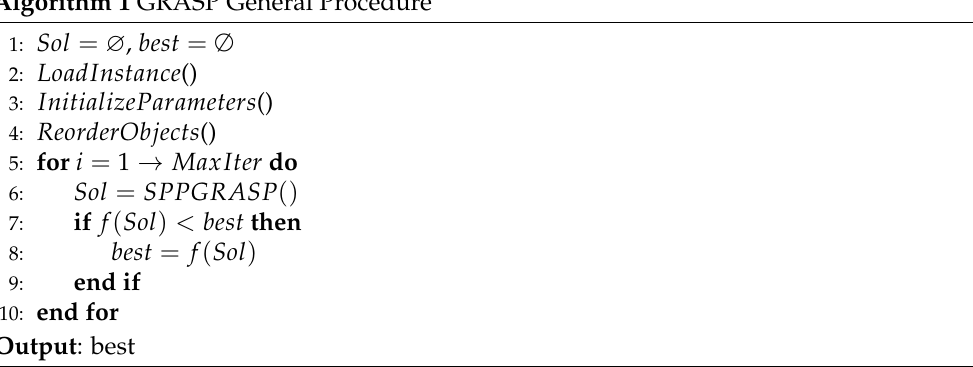
Algorithm 1 GRASP General